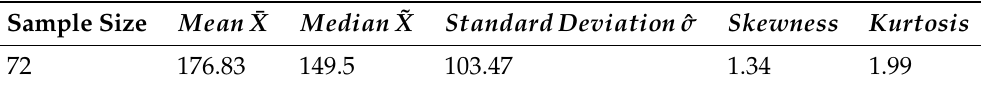
Table 25. Summary statistics of